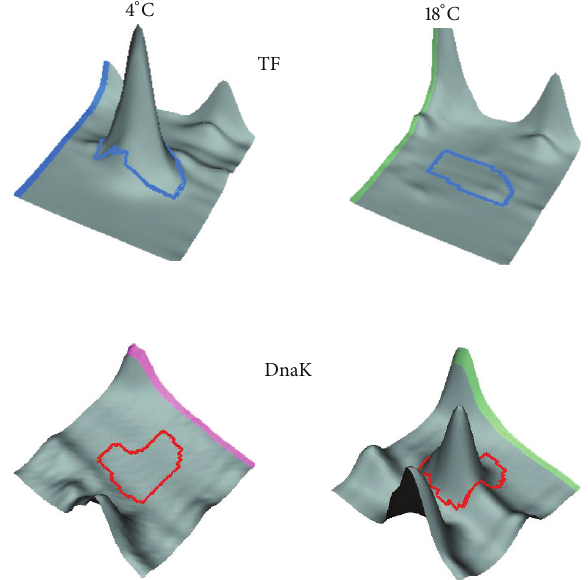
F 2: Comparative analysis of electrophoretic spots containing the trigger factor TF and DnaK from P. haloplanktis grown at 4 C (right panels) illustrating the overexpression (le panels) and 18 ofTF(acoldshockprotein)andthedownregulationofDnaK(aheat ○ shock protein) at low temperature. Adapted from [83].